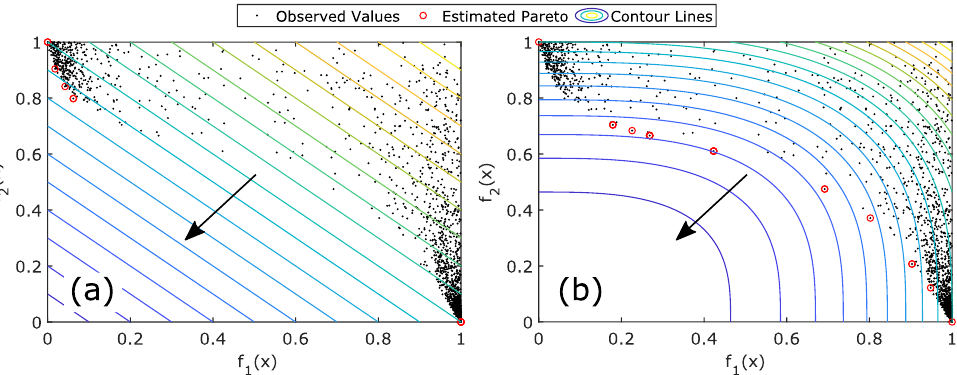
Figure 8. Estimated optimal points (red circles) in a non-convex Pareto frontier with different FoM combinations with contour lines of the combined objective function for λ = 0.5. ( a ) Linear combina- tion ( k = 1), ( b ) non-linear combination ( k = 3). The arrows indicate the combined minimization of the two scaled FoMs.